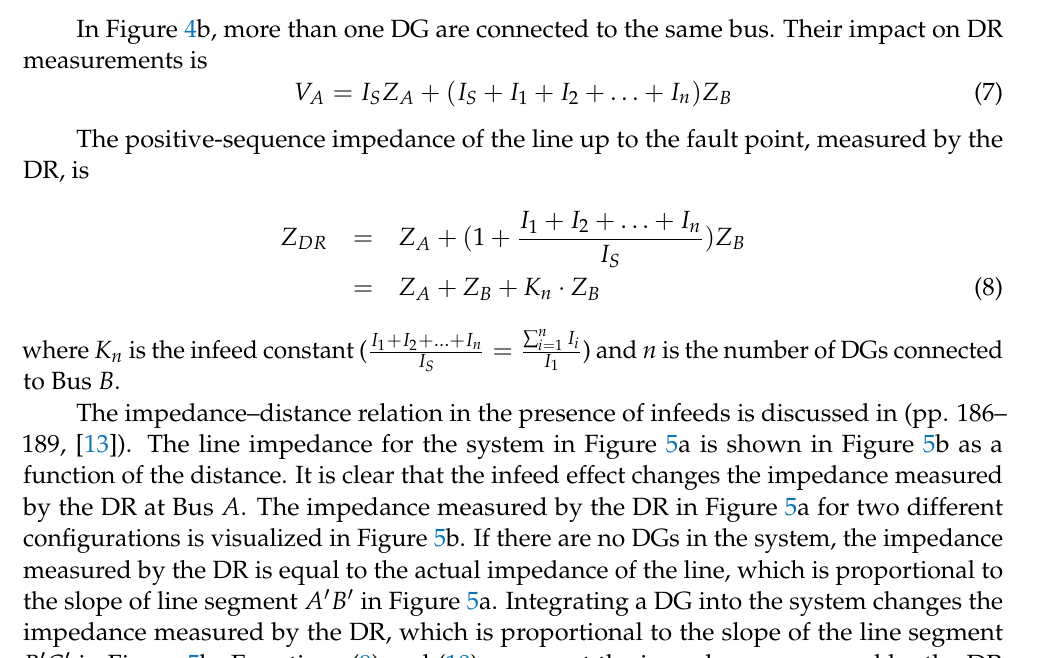
Figure 4. Infeed effect on distance protection: ( a ) radial distribution feeder with one DG; ( b ) radial distribution feeder with n DGs connected to the same